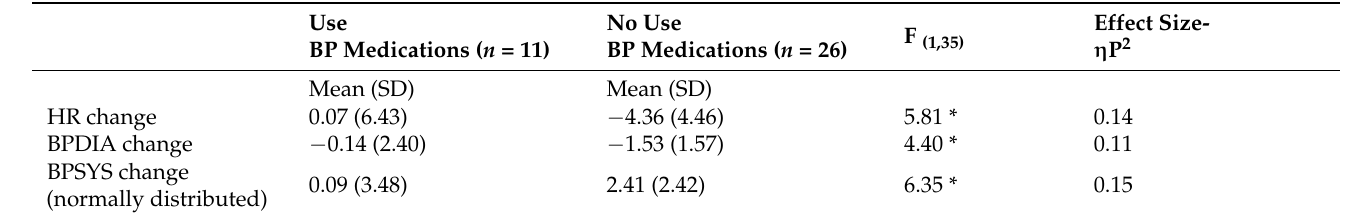
Table 2. Means, standard deviations (SD), statistical parameters, and significance levels of the physiological indices according to the usage of BP medications.